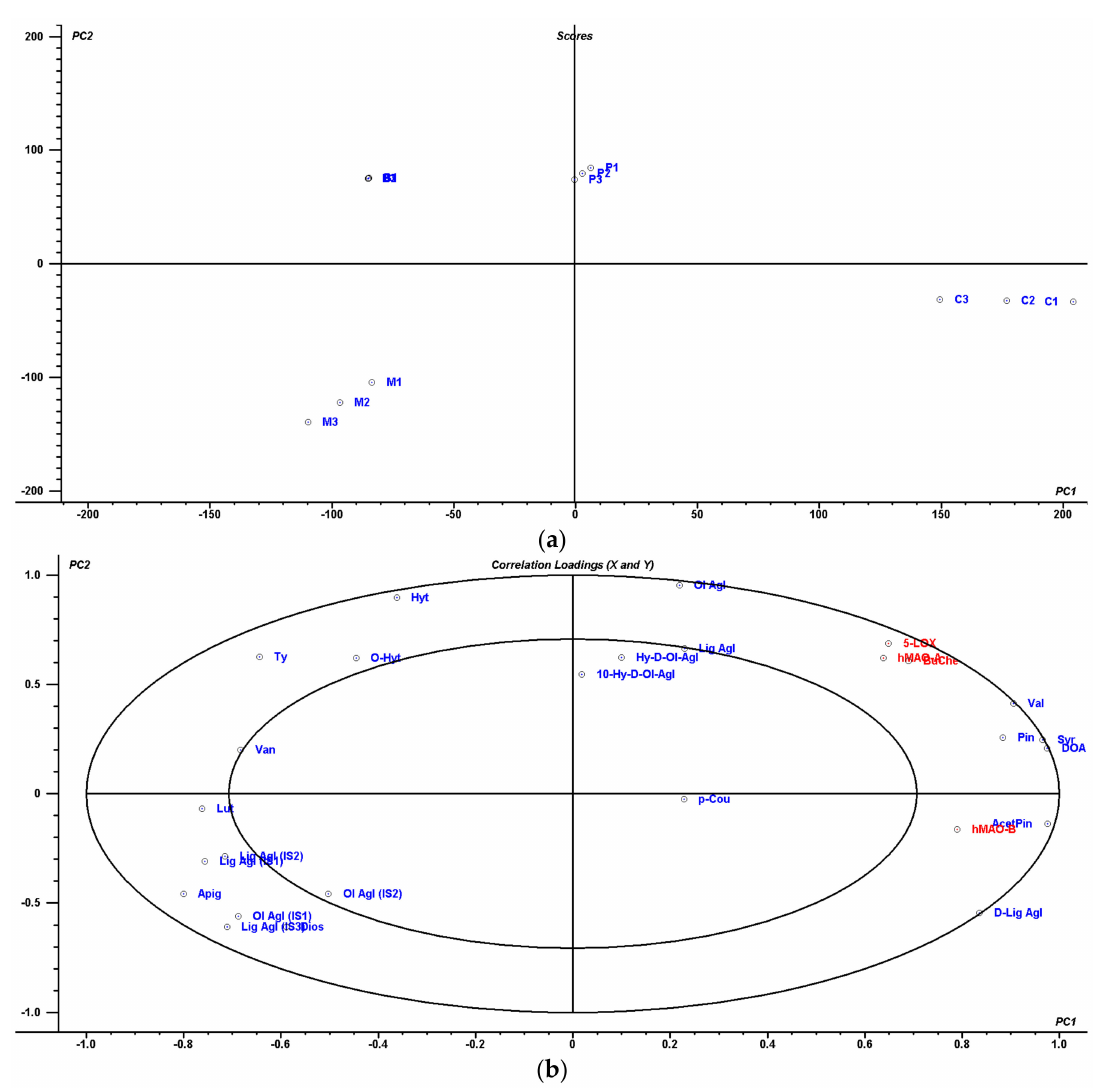
Figure 4. Two-dimensional PLS2: ( a ) scores plot for (cid:48) Mansa (cid:48) (M), (cid:48) Cornicabra (cid:48) (C), (cid:48) Brava (cid:48) (B) and (cid:48) Picual (cid:48) (P) EVOOs, together with ( b ) correlations between the loadings of X (phenolic profiles in blue) and Y variables (IC 50 values in red). In the same way as for Figure 4, enzymatic variables of BuChE, h MAO-A and 5-LOX were highly correlated with phenolic variables of Val, Syr, DOA and Pin. All of them were closely connected to h MAO-B, which was highly correlated with AcetPin and D -Lig Agl. The rest of phenolic compounds were separated at higher similitude distances. Variables abbreviations are described in Figure